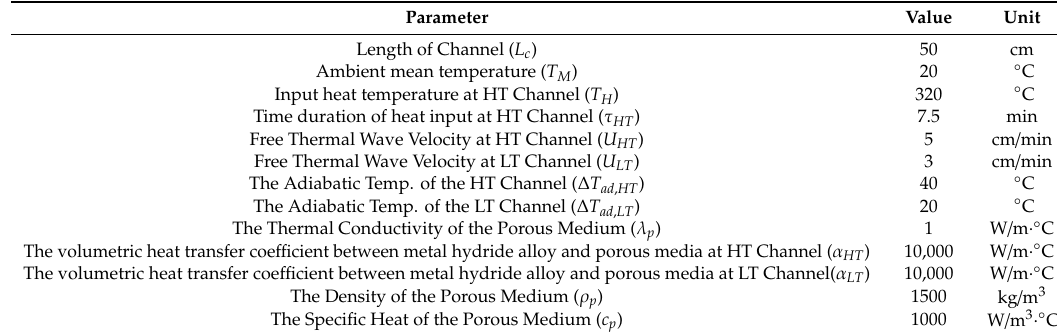
Table 2. The design and operation